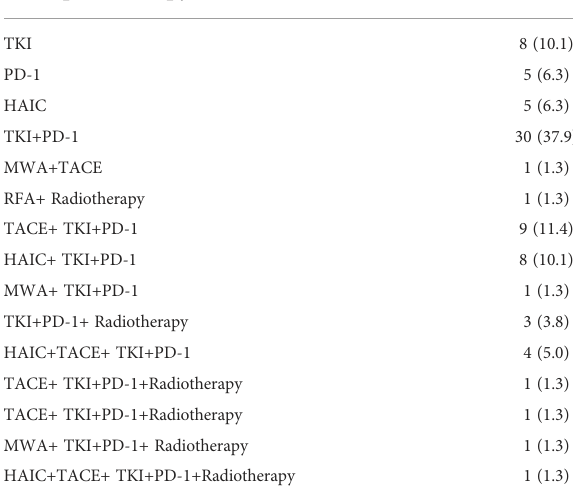
TABLE 4 Subsequent